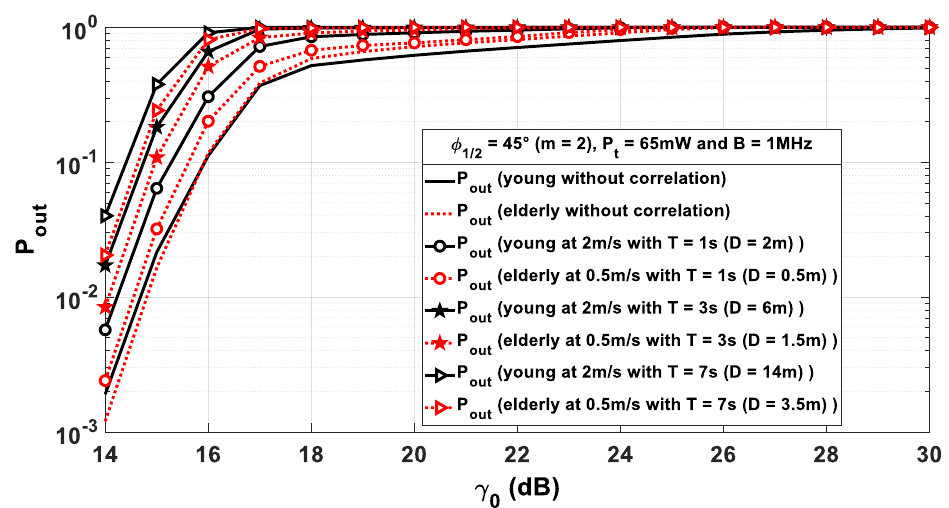
Figure 12. Outage probability P out as a function of γ 0 for different window sizes in terms of time duration T.